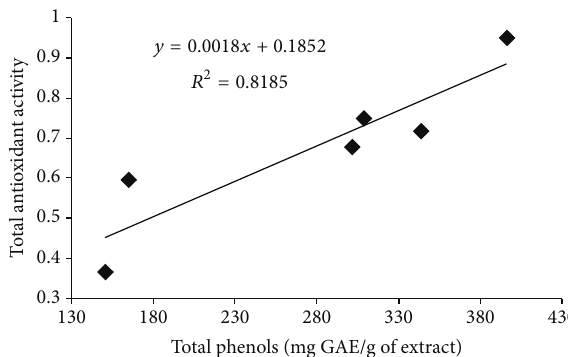
Figure 3. FRAP and total antioxidant activity were measured at different concentrations of extract to check the dose effect molybdenum ion).